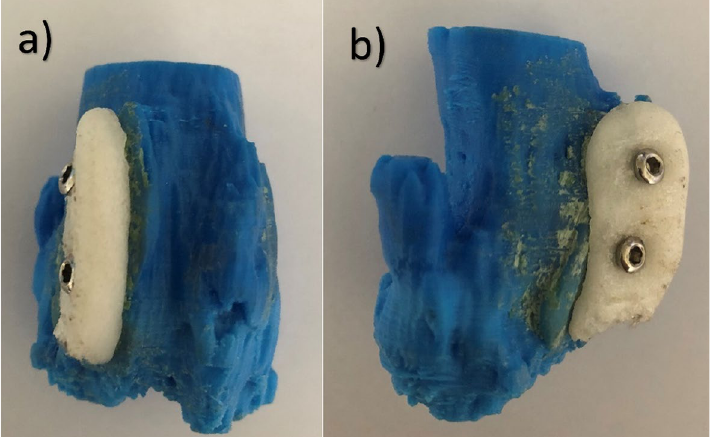
Figure 3. After the implant was printed the proper sitting was checked on the bone replica. Anterio-posterior view ( a ) and lateral view ( b ) of the implant on the bone replica. Inner surface of the implant fits very well with surface of the bone